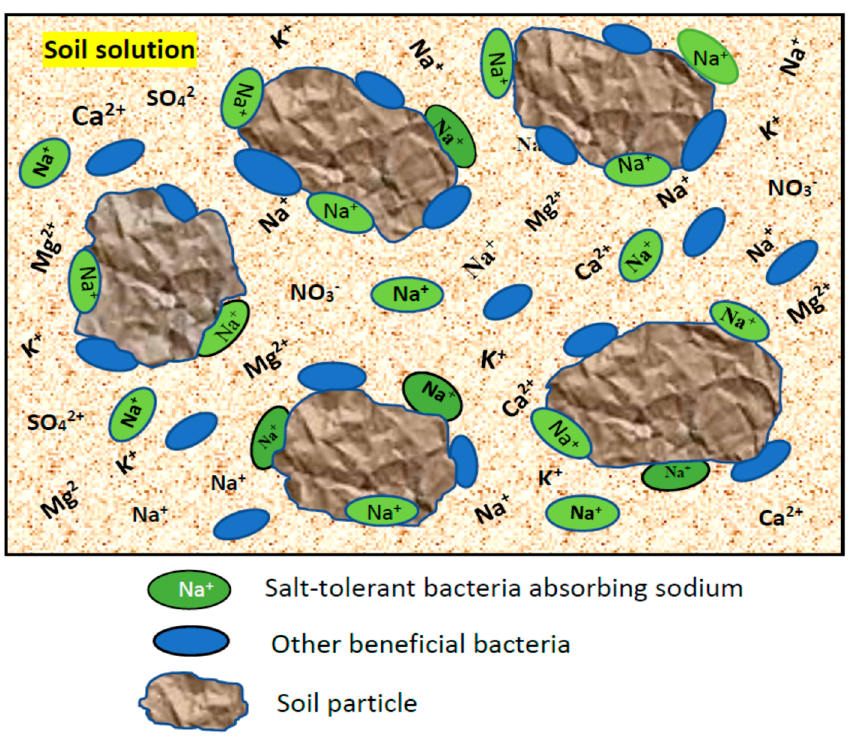
Figure 1. Sodium absorption by the EPS producing salt-tolerant bacteria under saline